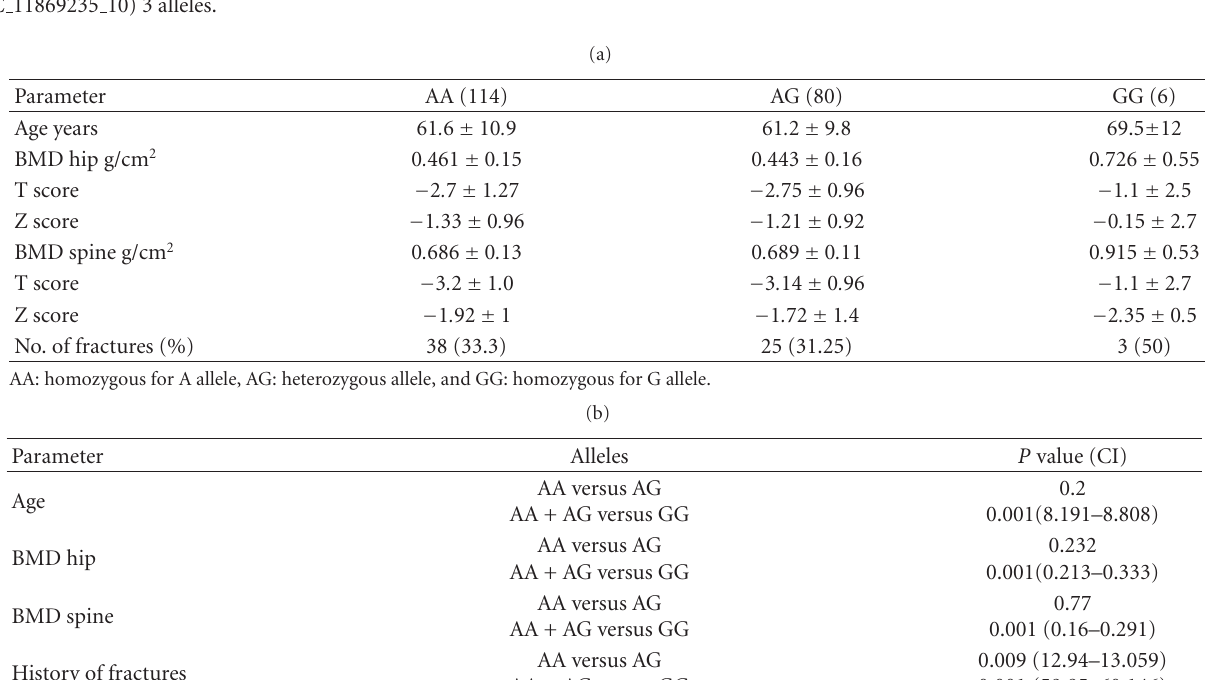
Table 3: (a) Demographic data of TNFRSF11B (C 11869235 10) of AA, AG, and GG allele. (b) Statistical analysis of the TNFRSF11B (C 11869235 10) 3